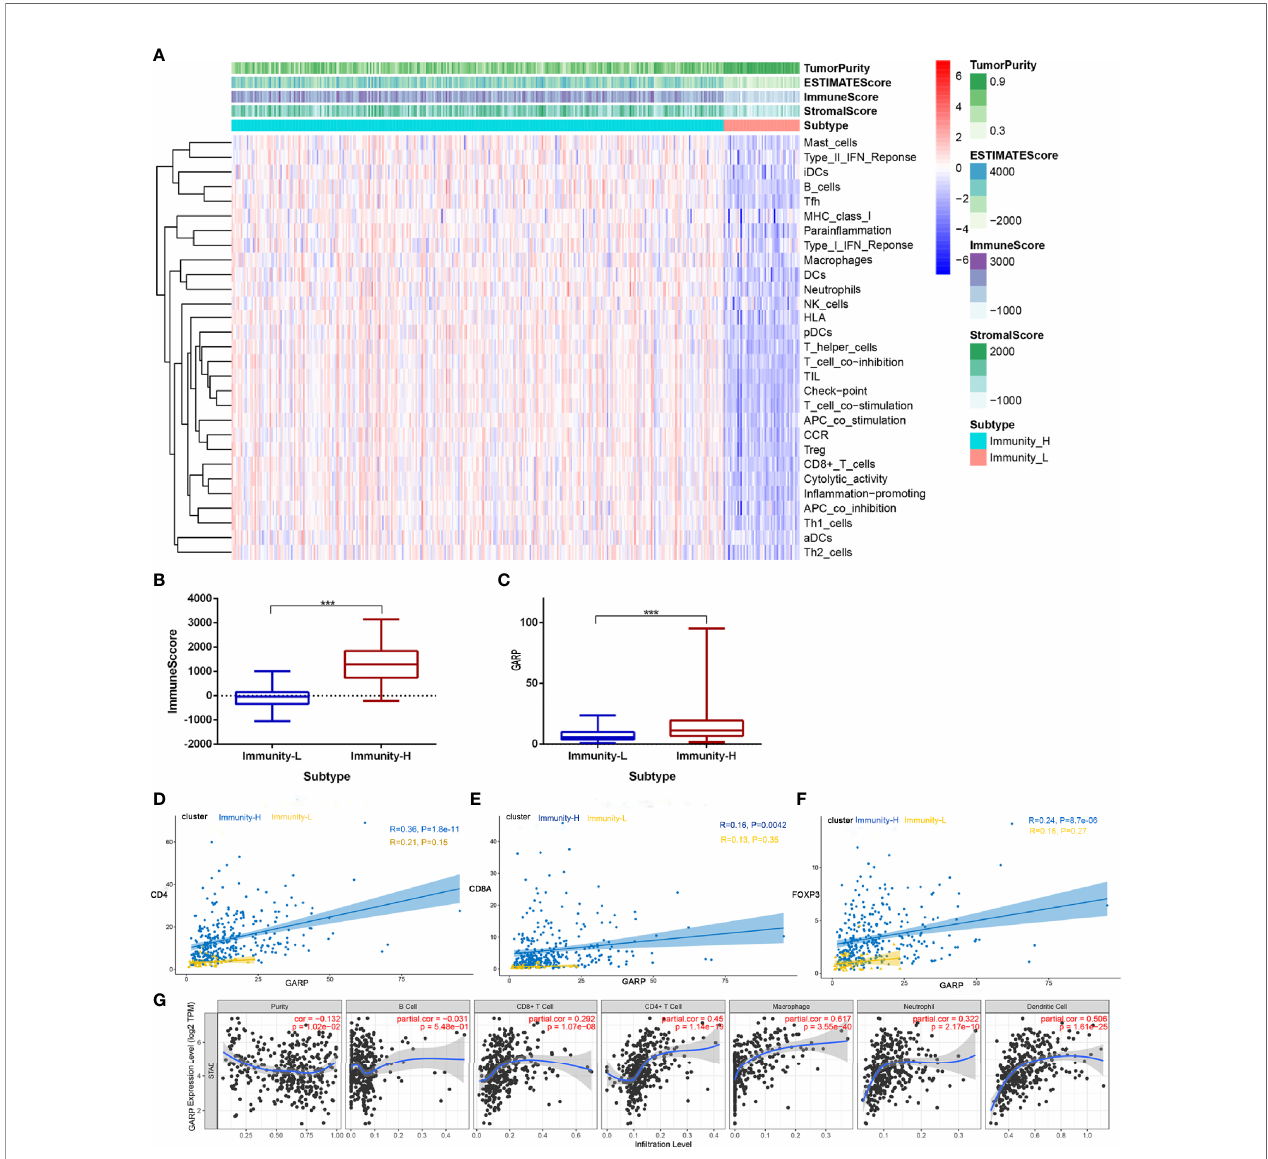
FIGURE 1 | (A) Immune cell score, stroma cell score, comprehensive scores of immune and stromal cells, and tumor purity score in different immunity groups. (B) Analysis of the difference of the immune score between the high and low immunity groups. (C) Analysis of the difference of glycoprotein A repetitions predominant (GARP) expression between the high and low immunity groups. (D – F) The relationships of GARP with CD4, CD8A, and forkhead box protein 3 (FOXP3) in different immune groups. Immunity-L, low immunity group; Immunity-H, high immunity group. ***, P < 0.001. (G) Correlations between GARP expression and immune cells in fi ltration levels in